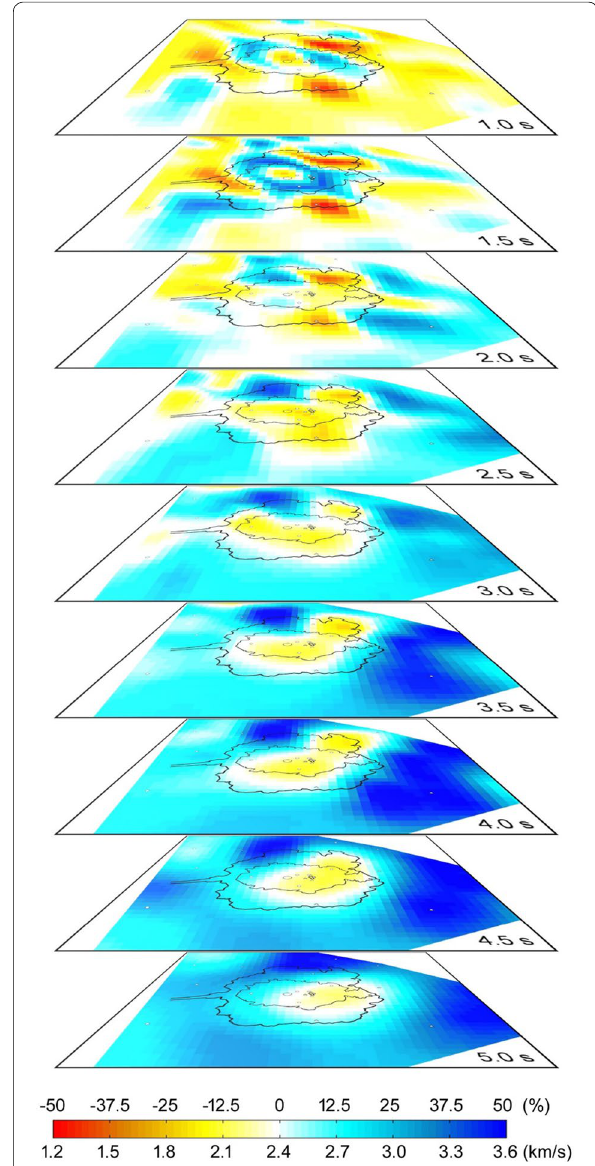
Fig. 13 Overlapping phase‑velocity maps for nine periods in the 1–5‑s period band at 0.5‑s intervals. Velocity range is identical for